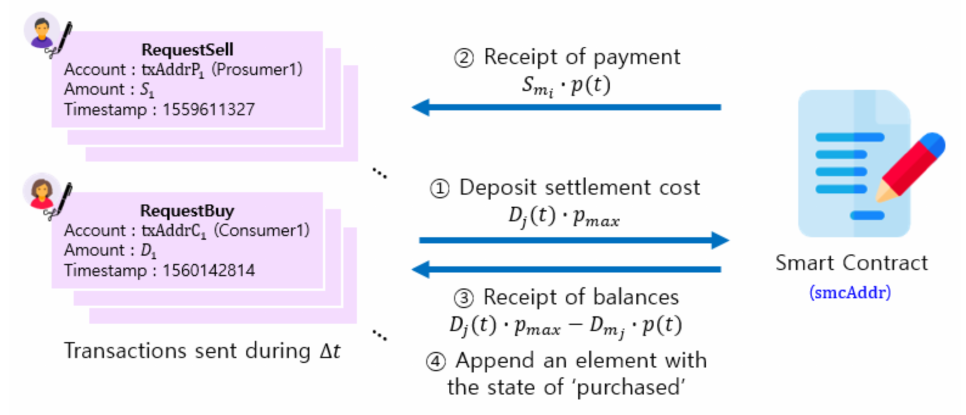
Figure 10. The process of payment between prosumers and consumers in the energy trading.